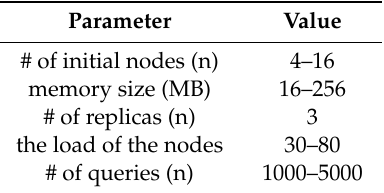
Table 1. Performance evaluation parameters.